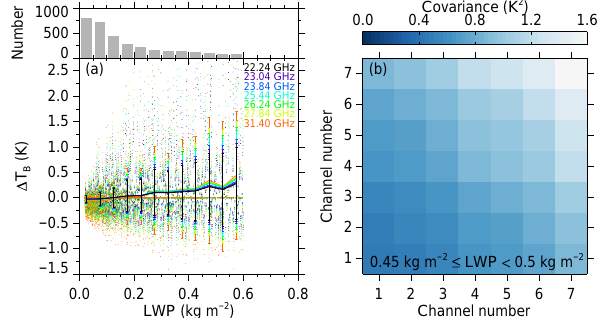
Figure 4. (a) Brightness temperature difference as a function of LWP (dots) using two different LWC assumptions. The colours in- dicate the according frequencies (top right). The mean and the stan- dard deviation per bin size are indicated by coloured lines and error bars, respectively. The bin size amounts to 0.05kgm − 2 . The num- ber of occurrences is given in grey bars at the top. (b) Exemplary covariance matrix for an LWP between 0.45 and 0.5kgm − 2 . The channel numbers correspond with the HATPRO frequencies given in (a) , which means, for example, that 1 refers to